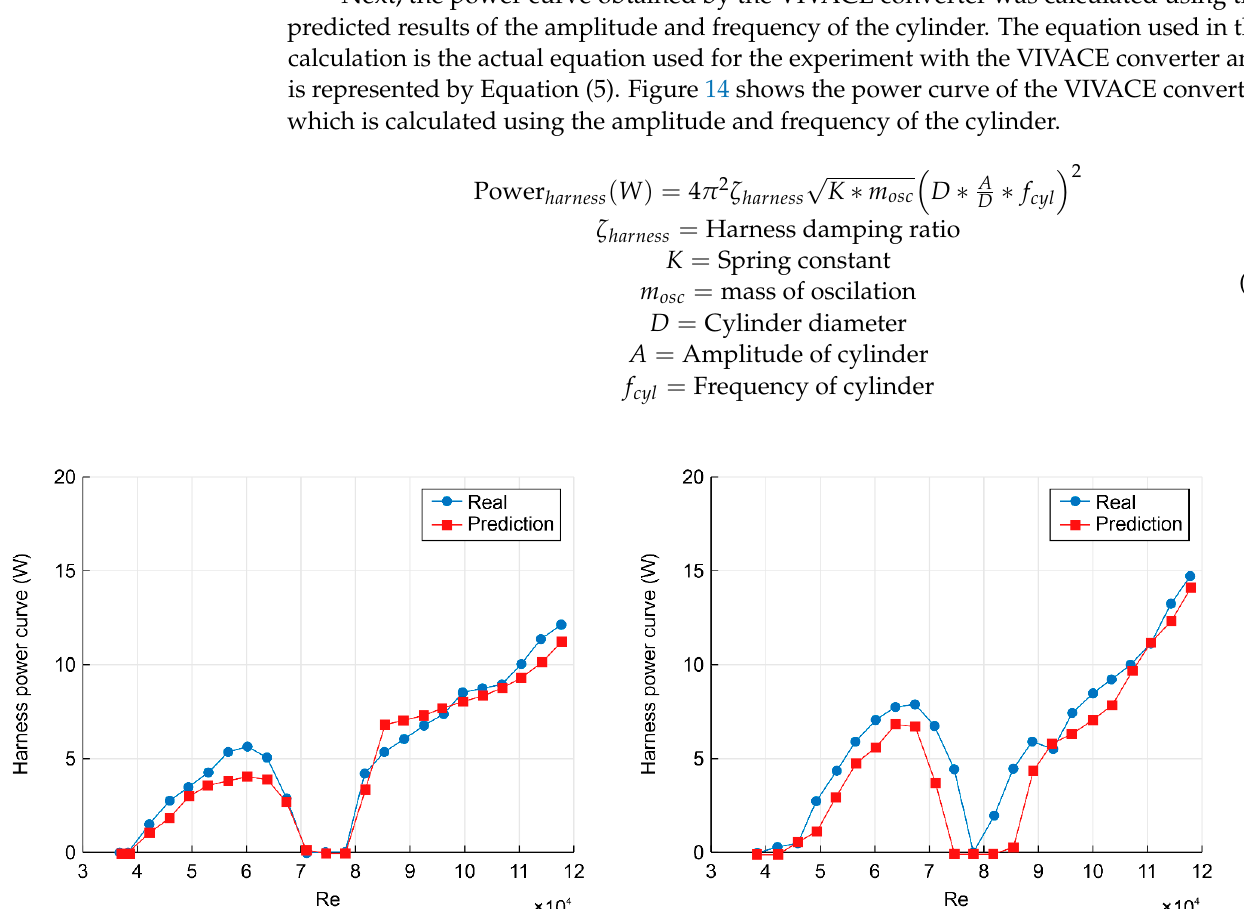
Figure 15. Power curves for untested data with K and ζ harness as parameters.